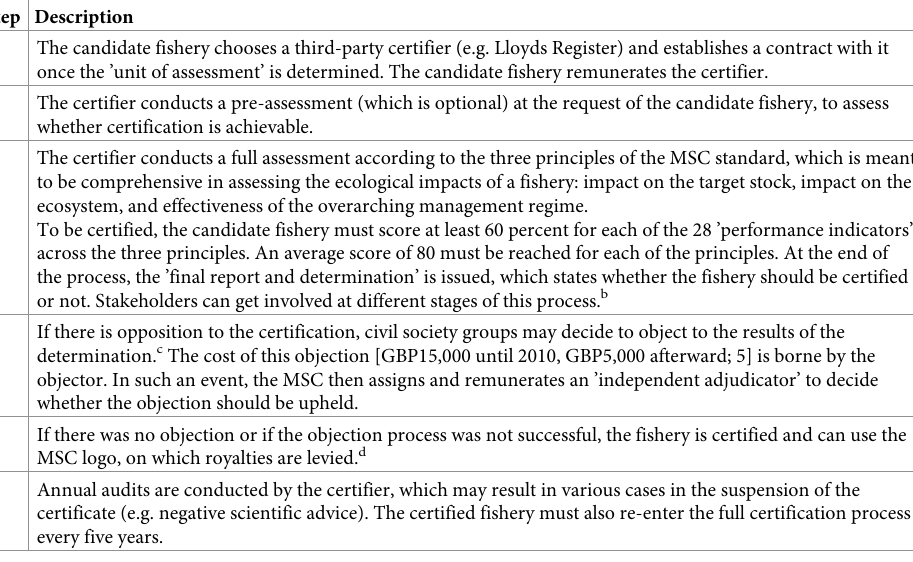
Table 1. Summary of the certification process a . Source: